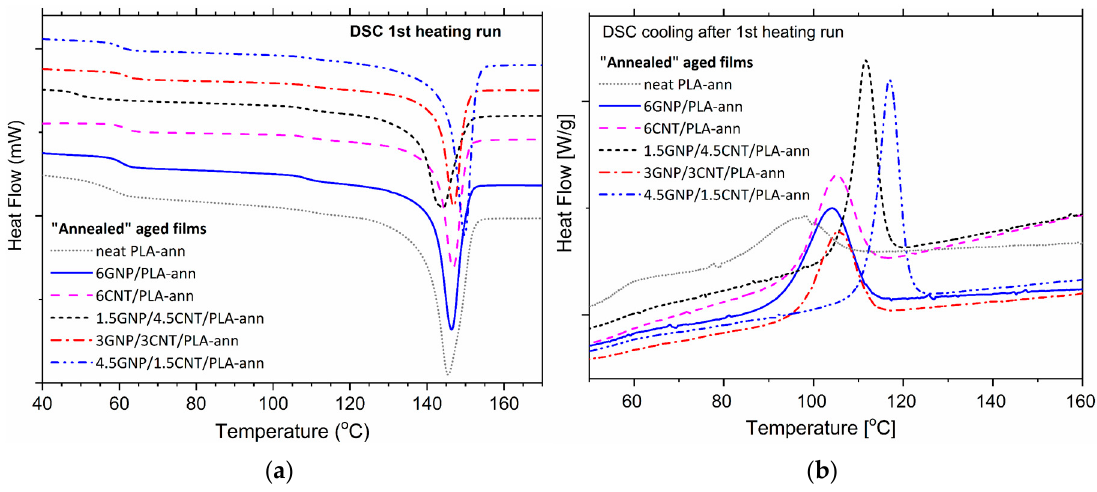
Figure 4. DSC thermograms of the “annealed” aged films at 80 °C for 4 h: ( a ) first heating run at 10 °C/min, and ( b ) subsequent slow cooling of the melt at 1 °C/min after the first heating run.